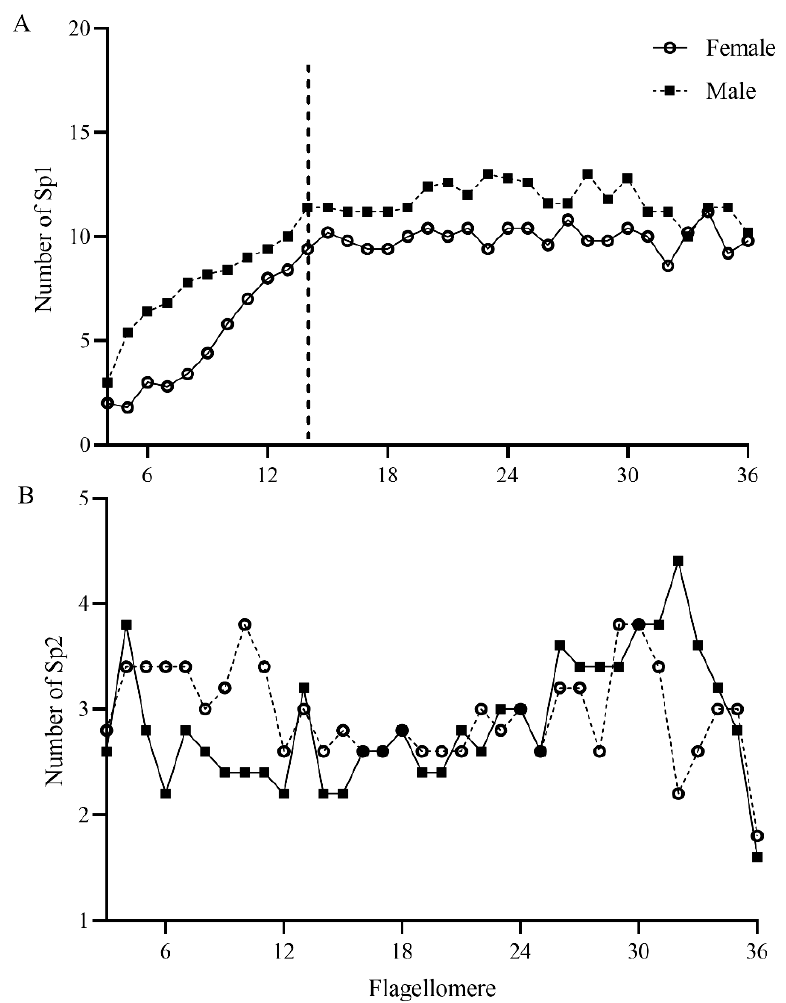
Figure 9. Numbers of sensilla placodea 1 ( A ) and 2 ( B ) on antennal flagellum of both sexes of C. qinlingensis (N = 5). As the dashed line shown in ( A ), the number of Sp1 increases gradually from flagellomere 1 to flagellomere 14 (left) but is almost the same among other flagellomeres (right).